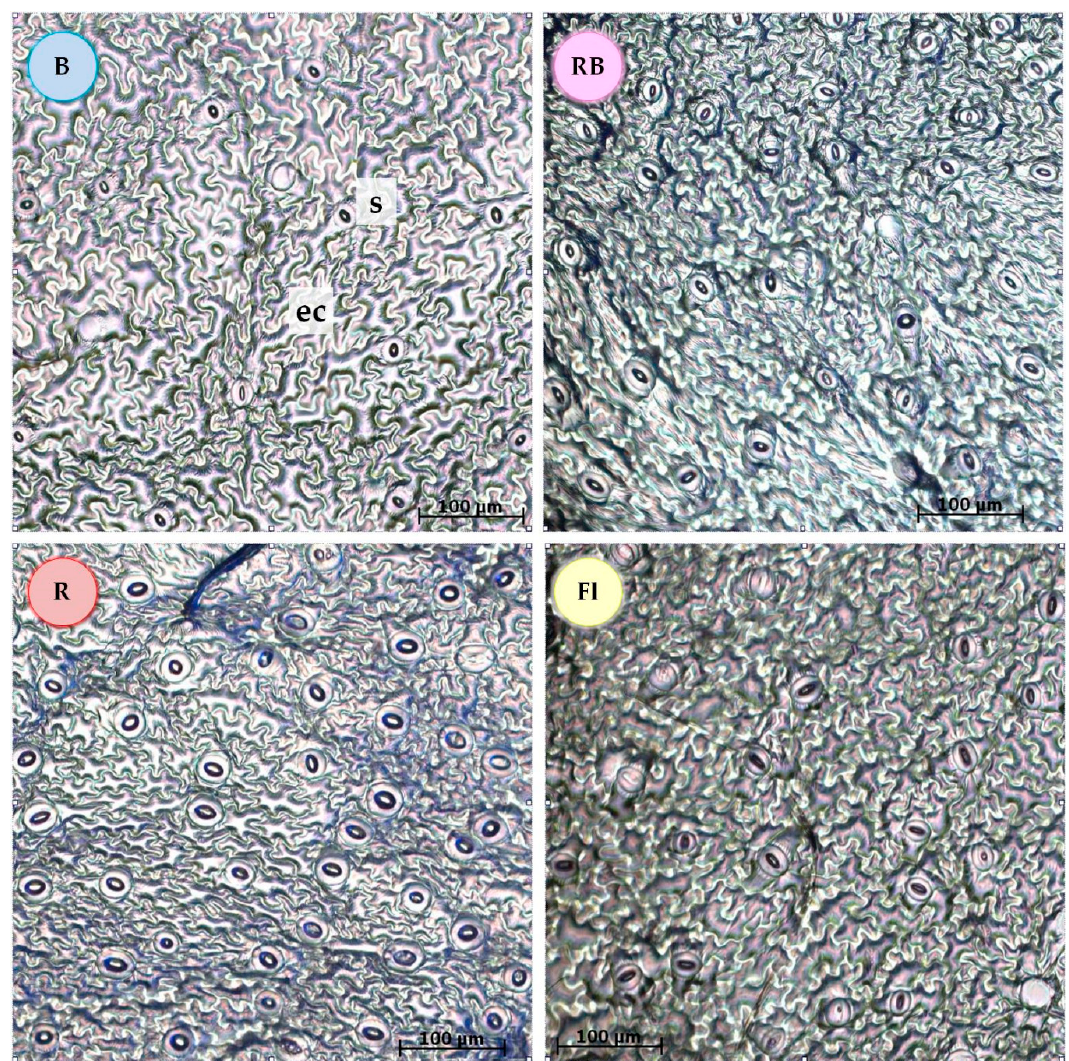
Figure 2. Abaxial side of a leaf blade in vitro with stomata after 6 weeks of shoot multiplication in the medium with 5 µM BA, under different light qualities. B—100% blue light-emitting diode (LED); RB—mixed red and blue LED (7:3); R—100% red LED; Fl—control, white fluorescent light; visible area, 500 × 500 µm; ec—epidermal cells; s—stomata; scale bar, 100 µm. Table 2. Characteristics of the stomata in gerbera leaves after 6 weeks of in vitro cultivation of shoots depending on the quality of light and the concentration of BA in the medium.